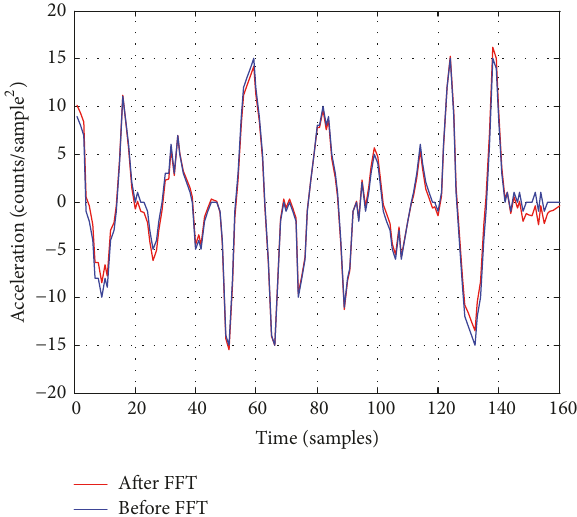
Figure 14: The waveforms of the acceleration before FFT and after